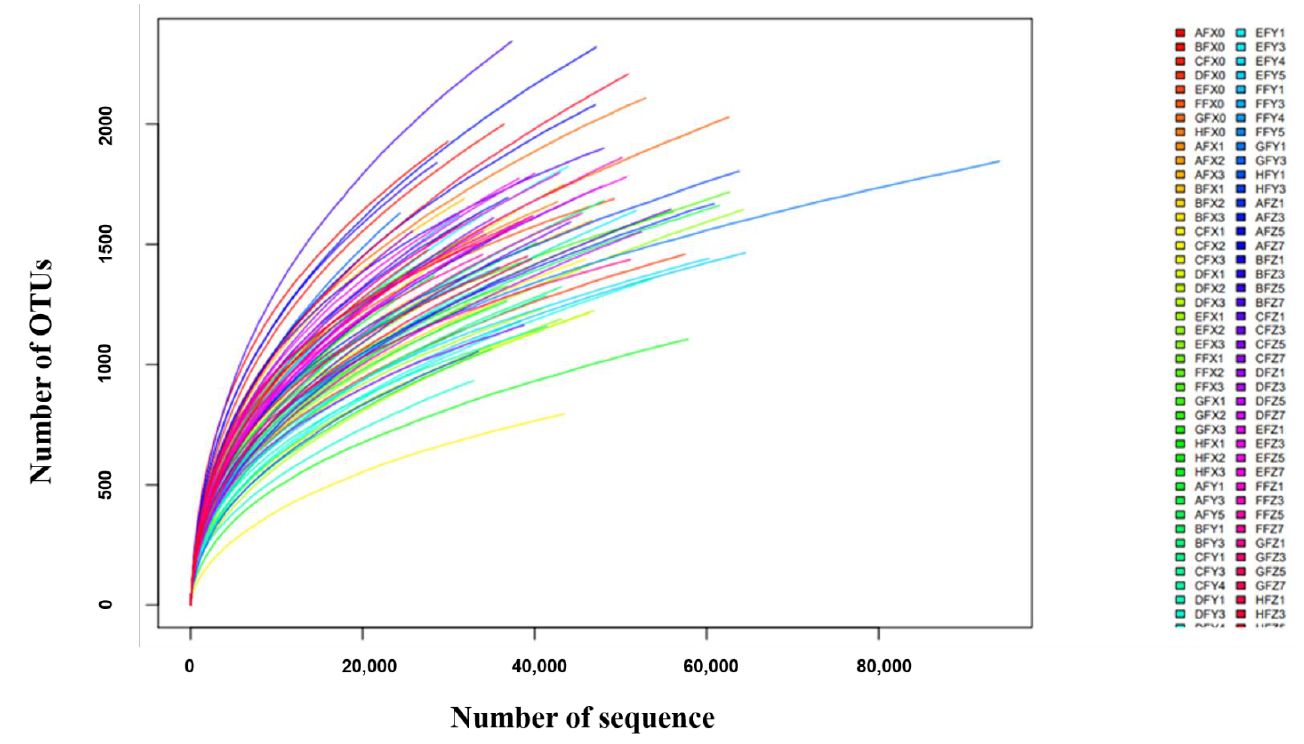
Figure 1. The rarefaction analysis performed using mothur. The rarefaction curve based on the species diversity showed sufficient coverage for the sequences. The first letter of the number (A–H) represented the different cows. X0, X (X1, X2, X3), Y (Y1, Y3, Y4, Y5), and Z (Z1, Z3, Z5, Z7) indicate the periods Day 0, medication, withdrawal, and recovery, respectively.